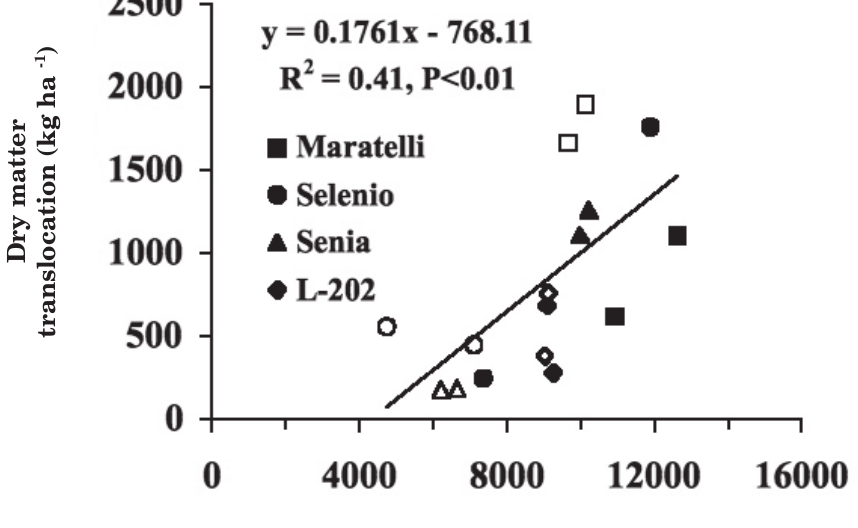
Fig. 4. Relationship between dry matter accumulated at anthesis and dry matter translocation in rice. The relationship was based on the means derived from four rice varieties, two disease treatments and two years (2003, filled symbols; 2004, empty symbols) of experimentation